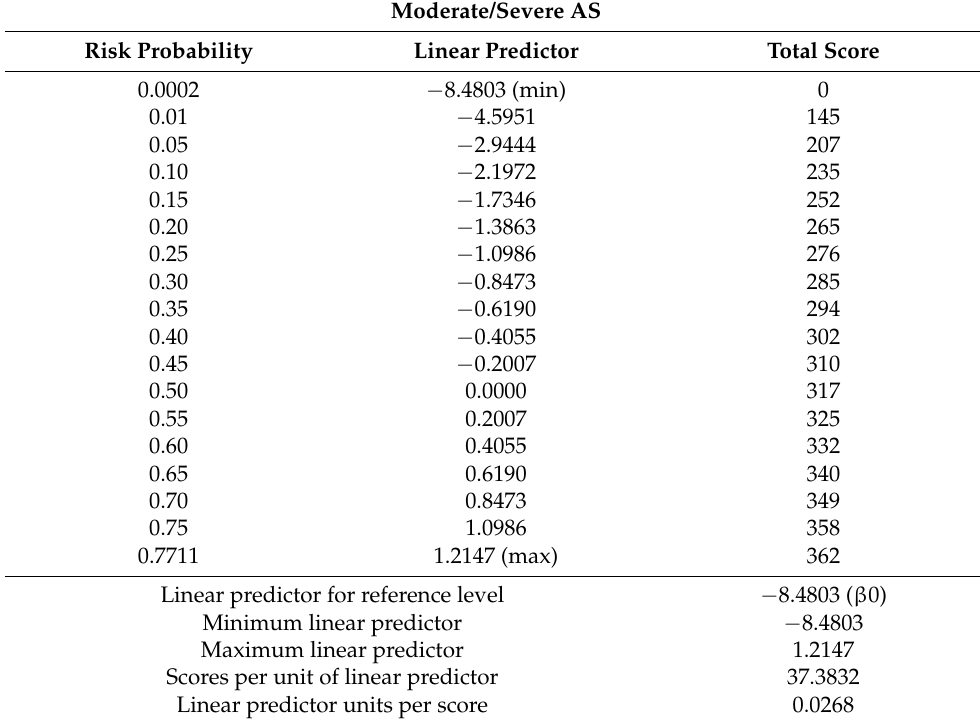
Table 4. Linear project to the risk probability and total